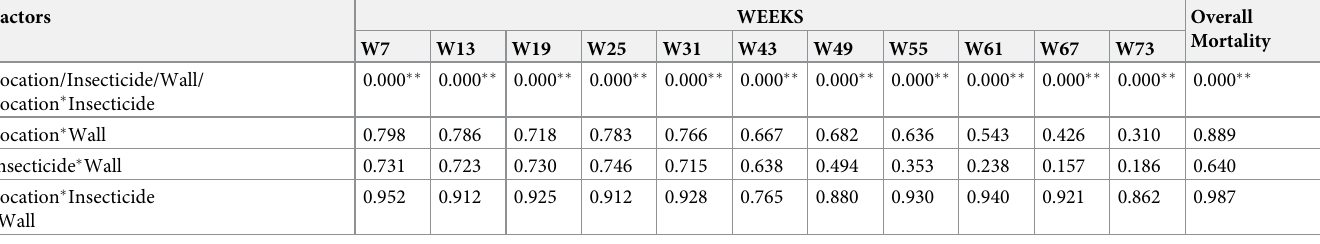
Table 1. Summary of ANOVA (p-values) based on weeks and overall mortality. Factors WEEKS Overall